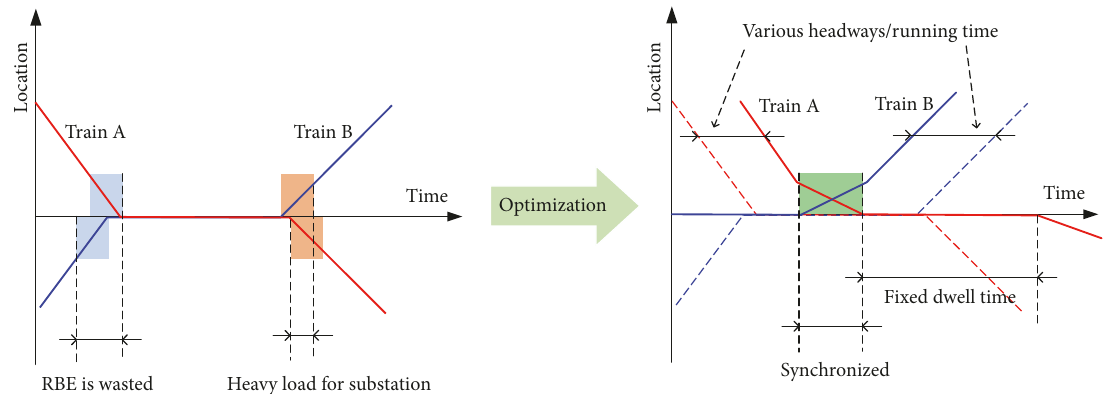
Figure 5: Energy-saving methods in integrated